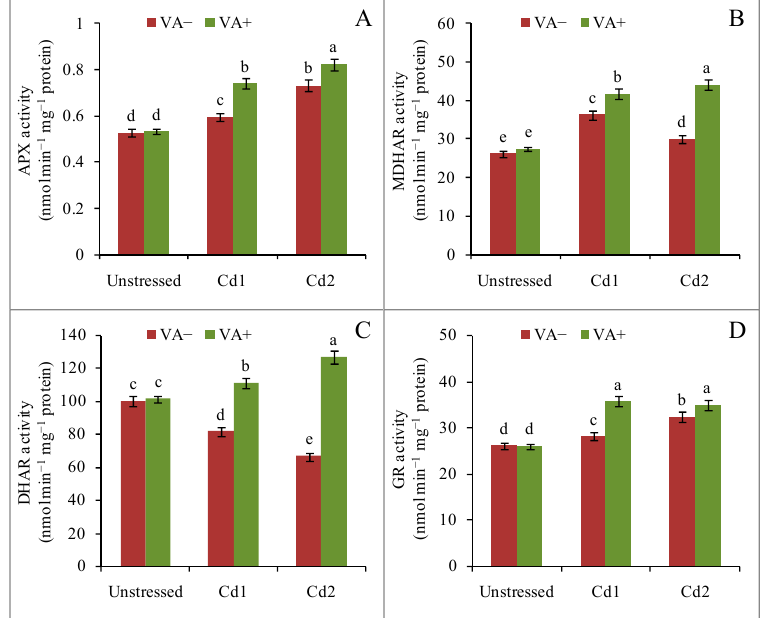
Figure 6. Effects of exogenous VA on activities of ascorbate peroxidase (APX) ( A ), monodehydroascorbate reductase (MDHAR) ( B ), dehydroascorbate reductase (DHAR) ( C ), and glutathione reductase (GR) ( D ) activity of rice ( Oryza sativa L. cv. BRRI dhan54) seedlings under Cd toxicity stress. Mean (±SD) was computed from three replications of each treatment. Bars with dissimilar letters are significantly different at p ≤ 0.05 from Fisher’s least significant difference (LSD) test .